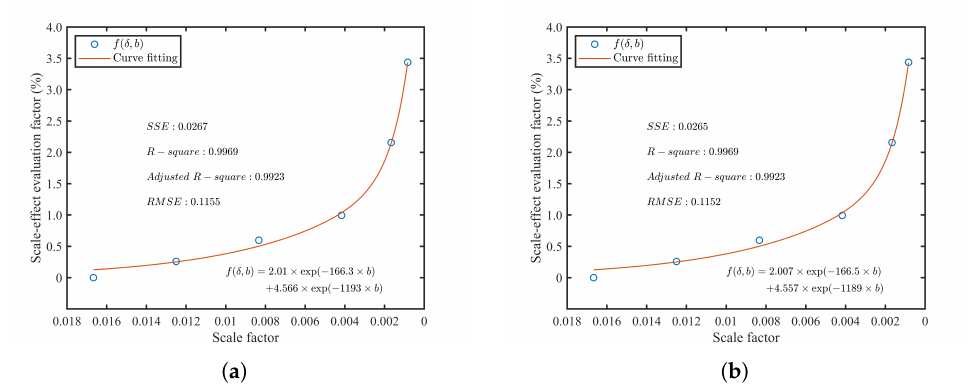
Figure 7. Scale-effect evaluation factor of multiscale DEMs based on the MRRT model under different illumination geometry: ( a ) (0 ◦ , 150 ◦ ) and ( b ) (45 ◦ , 150 ◦ ). Six scale factors are 1/60, 1/80, 1/120, 1/240, 1/600, 1/1200, respectively.